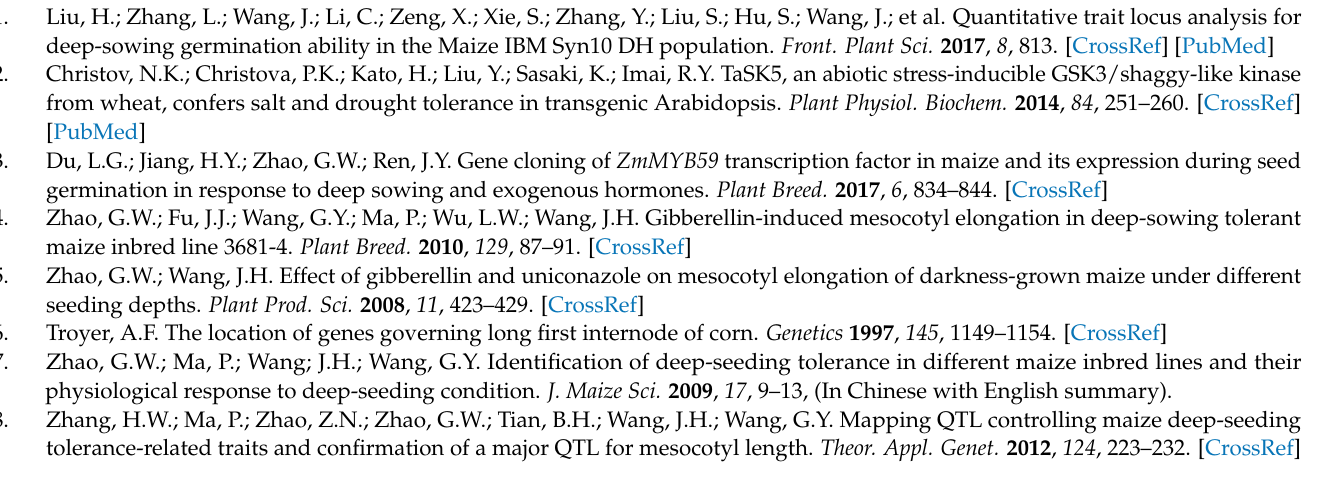
embryos. Heat maps illustrating the expression abundance of unigenes calculated by estimating FPKM values. Tables S1–S6: List of DEGs obtained in maize embryos of NS and DS. Table S7: Primer sequences of genes used for qRT-PCR